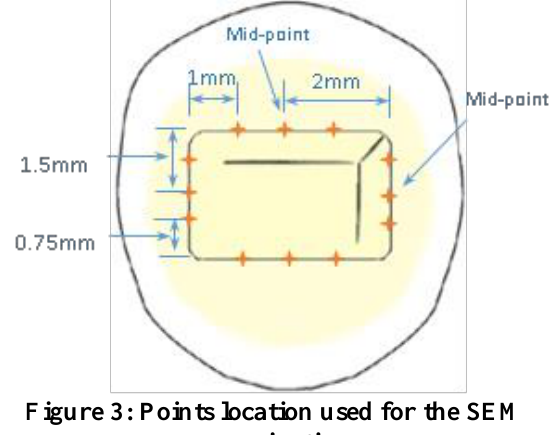
Figure 3: Points location used for the